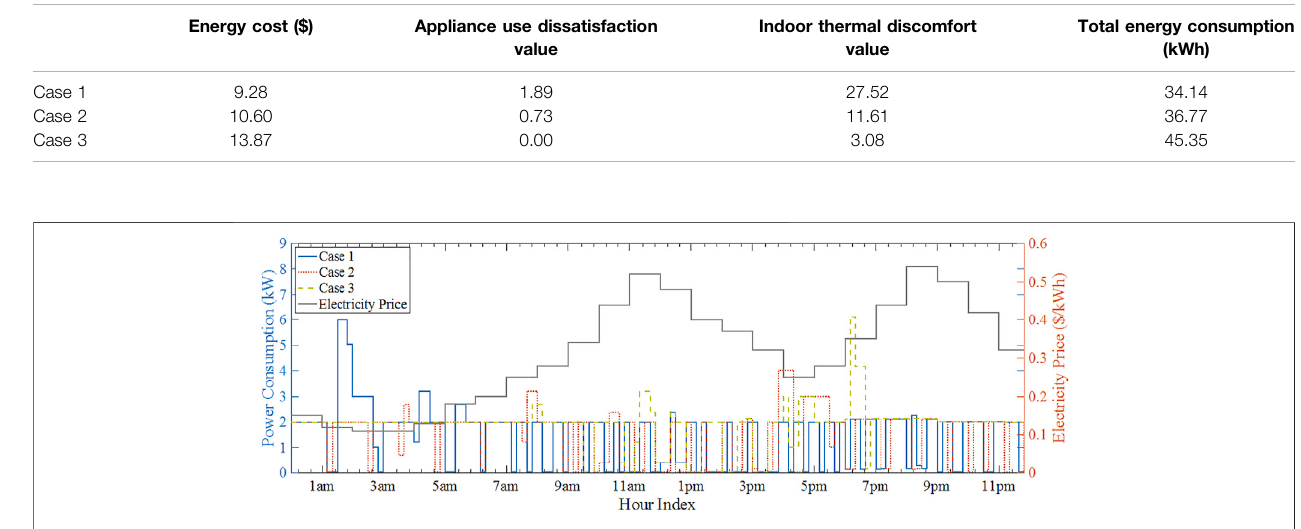
FIGURE 12 | Total power consumption pro fi les under the three cases.